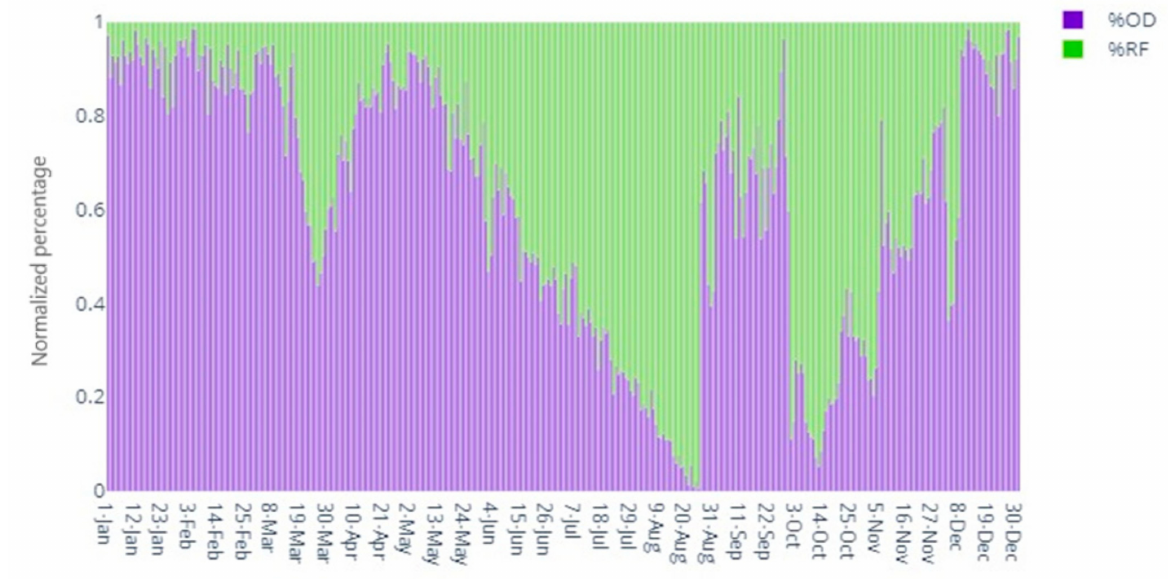
Figure 10. Comparison between the residual percentage of natural daily flow (green—%RF) remains in the river and the average daily discharge optimized for diversion (purple—%OD). The diverted discharge was calculated as a daily average for all 10 runs of the model. Presented results are for the DP1 under the dry